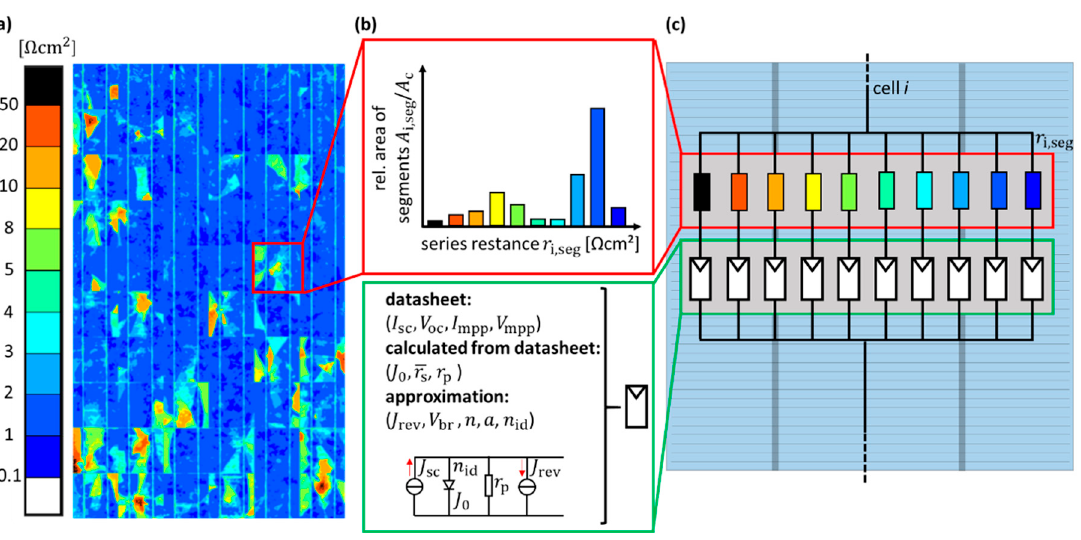
Figure 5. False color segmentation of series resistance mapping ( a ). Predefined and separated into ten segments with the relative area A i,seg / A c as a share of the total cell area A c , all cells are individually modeled, as shown by the area segmentation histogram in ( b ). The model shown in ( c ) contains the series resistance segments r i,seg and the constant diode model parameters extracted from the data sheet (green box). The ideality factor n id is identical for all cells and varied between 1.0 < n id < 1.4. The reverse characteristics for describing the reverse current density J rev depending on the breakdown voltage V br = − 15 V as well as the breakdown model parameters n = 2.3 × 10 − 3 and a = 1.9 are numerically modeled, as proposed by Quaschning [7]. From the data sheet, all other parameters are calculated, transposed into the series resistance map and scaled by the relative area of the segment. All cells i are connected in series and simulated with the bypass-diode configuration of the module.